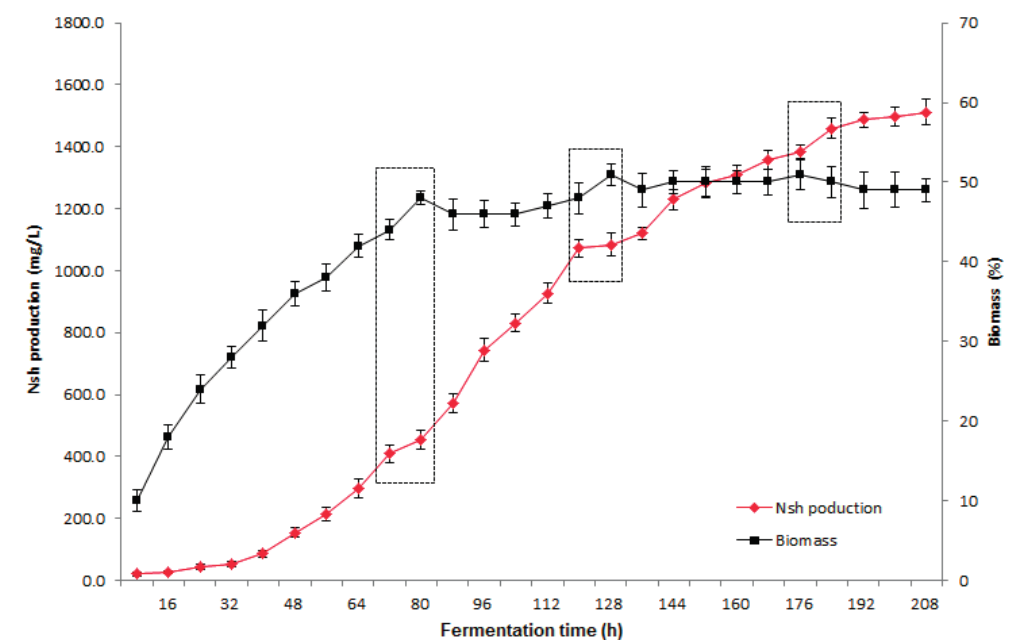
Figure 3. Time courses of biomass ( ■ ) and Nsh production ( ♦ ) under the optimal medium composition. The dashed frames indicate the time points of